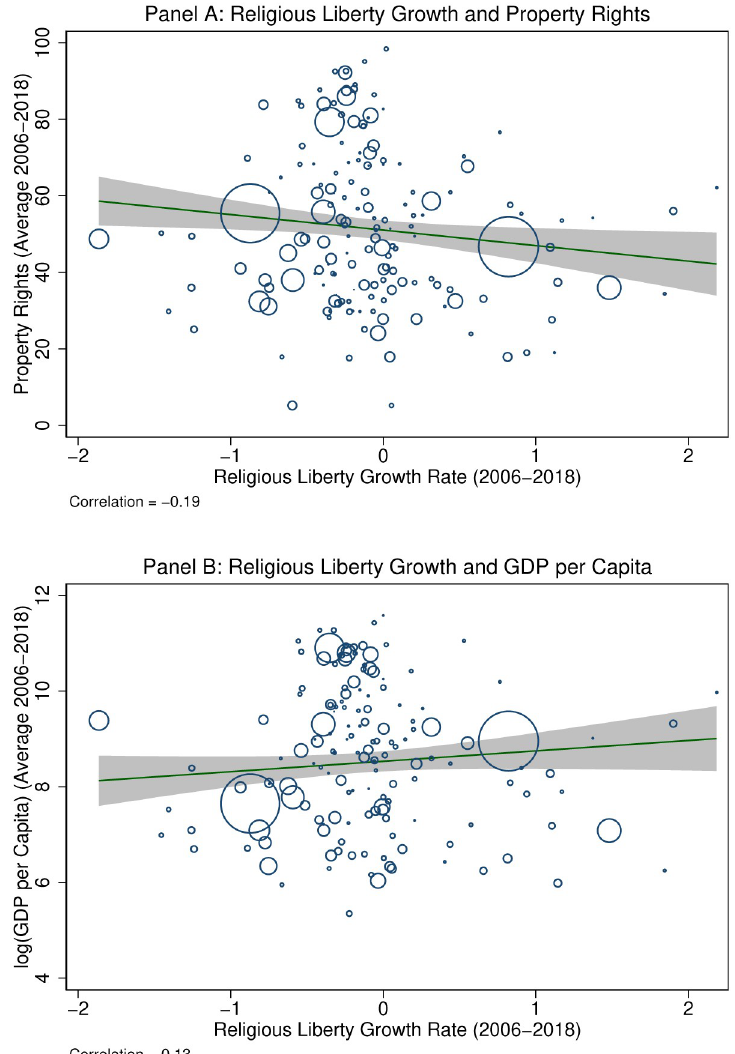
Fig 5. Growth in religious liberty and measures of economic development. Sources: Varieties of Democracy, World Bank, and Heritage Foundation. The figure plots the population-weighted relationship between the growth in religious liberty between 2006 and 2018 and an index of property rights and GDP per capita (averaged over 2006 and 2018 levels.